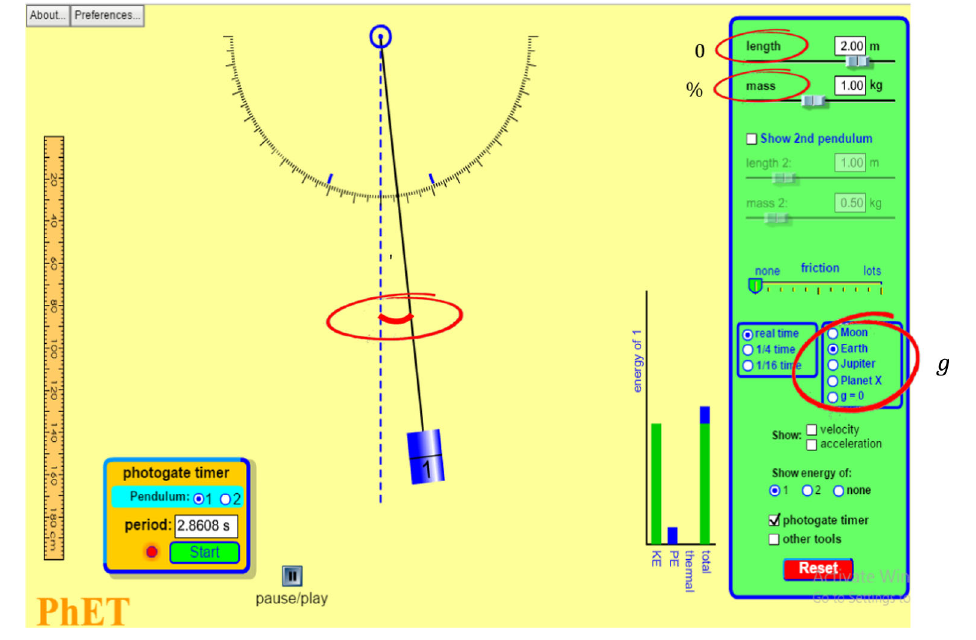
FIG. 5. Pendulum PhET.